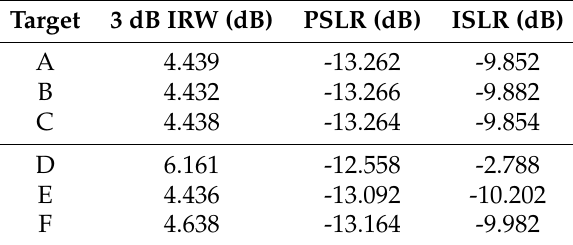
Table 2. Point target quality measurements.